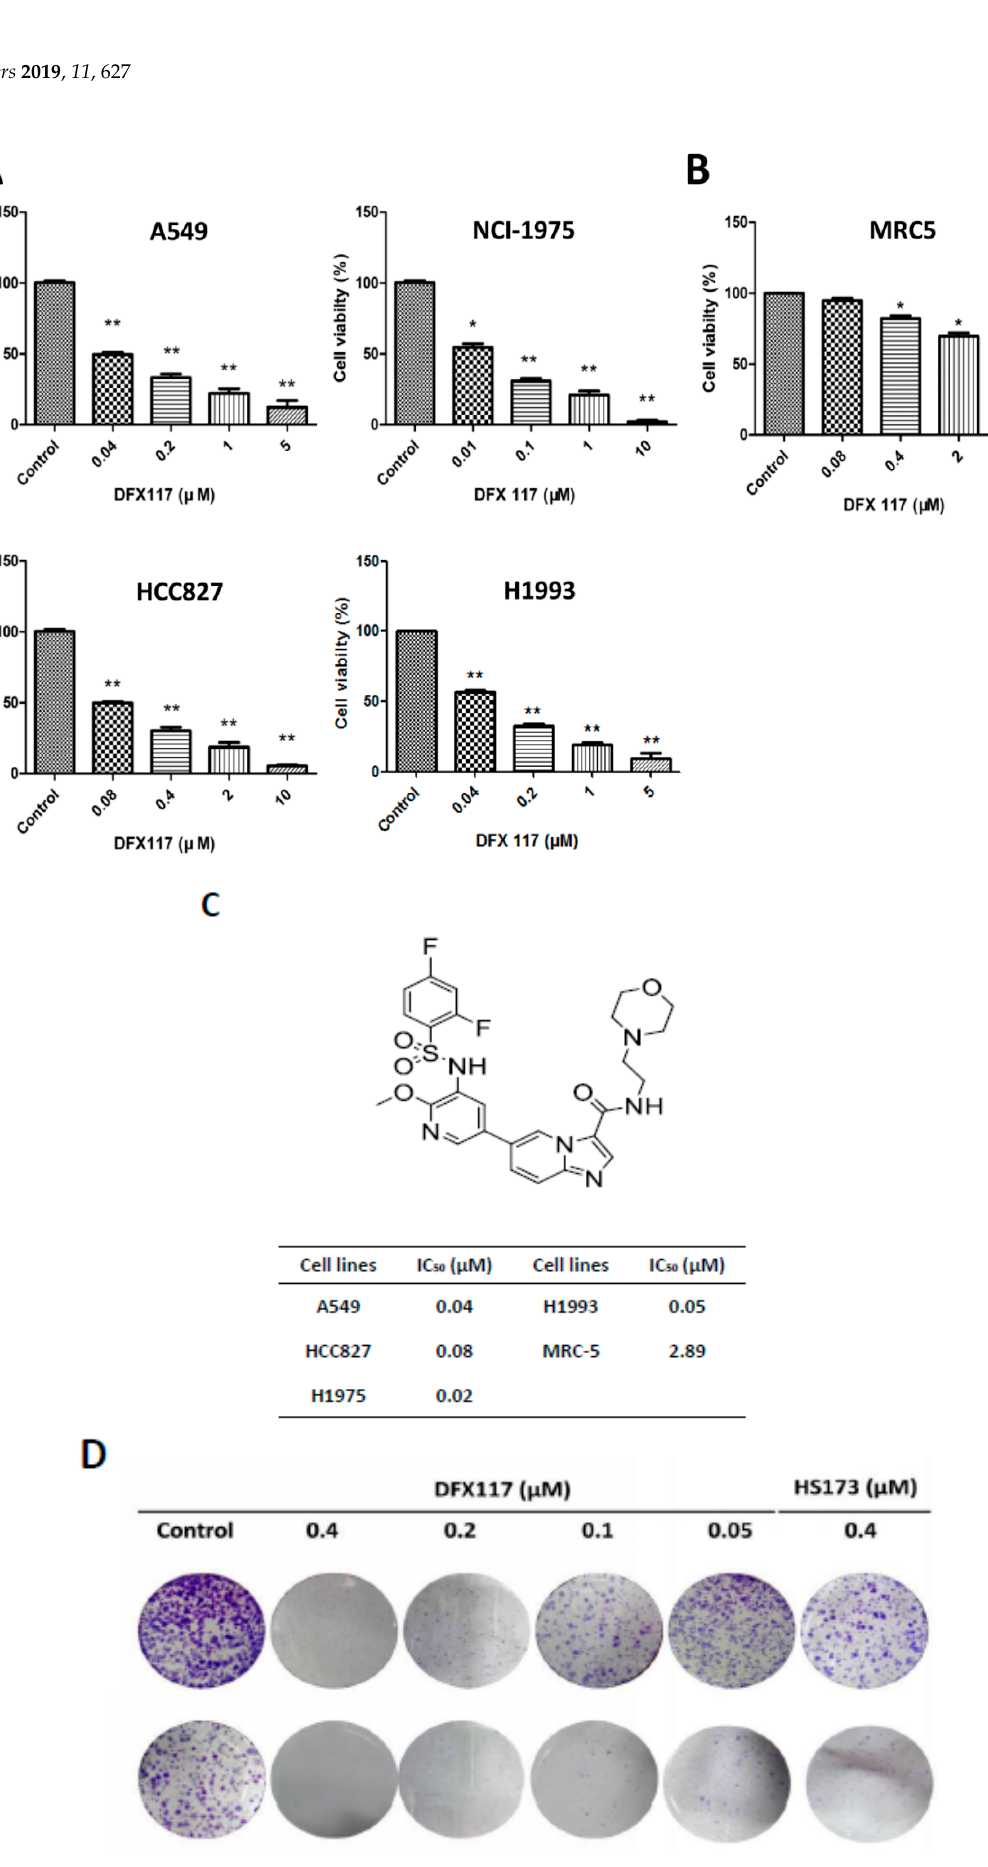
Figure 1. Cont Figure 1. Cont.